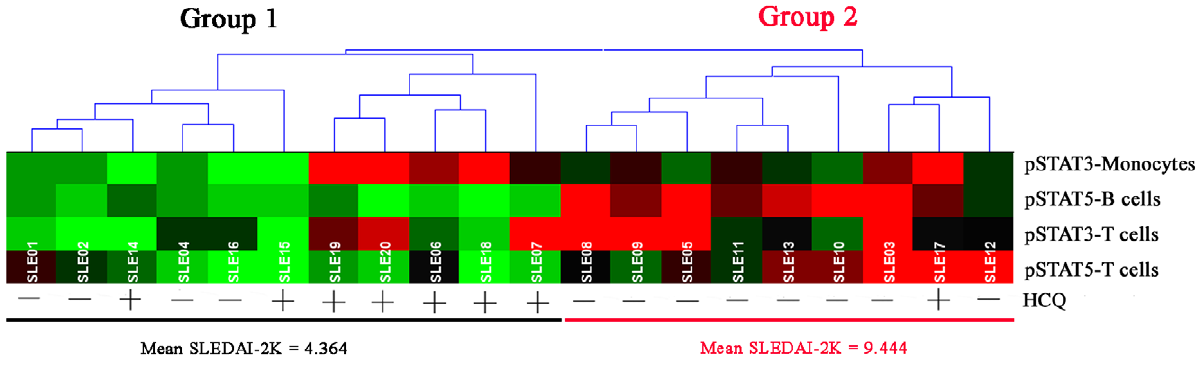
Figure 3. SLE samples were clustered by the expression of basal phosphorylated STAT3 and STAT5. Each grid represents the phosphorylation of a STAT protein in one cell type. The phosphorylation of each STAT protein was scaled relative to the minimum phosphorylation level among the 20 SLE samples.The 20 SLE patient samples were grouped according to their similarities using hierarchical clustering. Two groups of SLE patients were identified, based on similarities in the expression of basal phosphorylated STAT3 and STAT5 in specific cell types. HCQ use and the mean disease activity index (SLEDAI)-2K of each group are indicated at the bottom. SLE, systemic lupus erythematosus;HCQ, hydroxychloroquine.